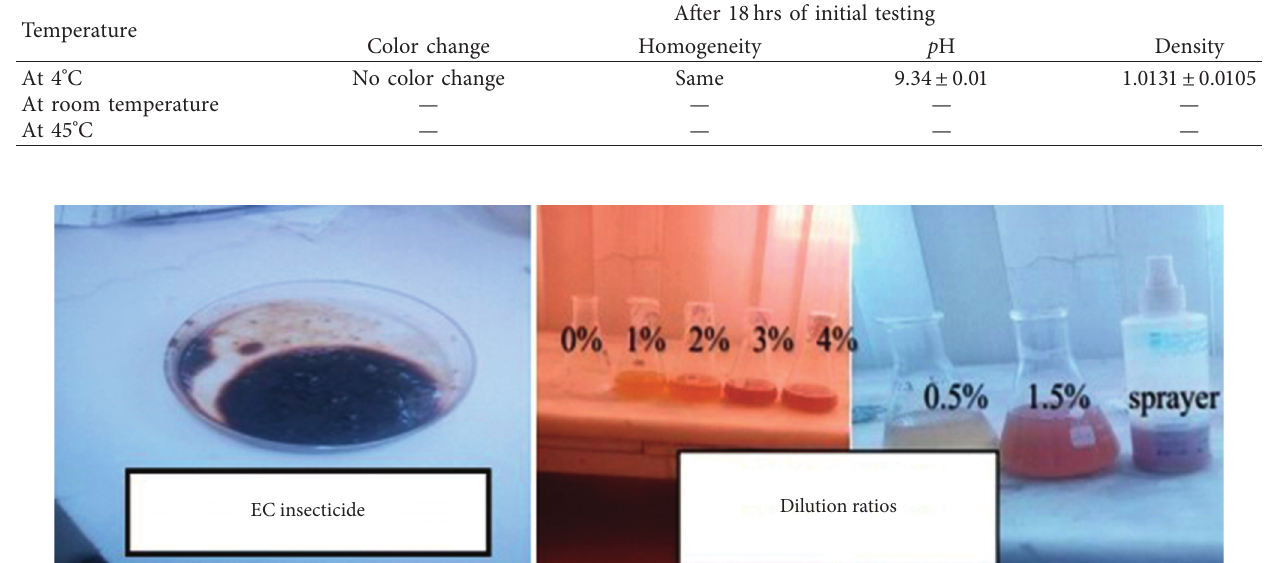
Figure 11: Efficiency testing of emulsified concentrates. Table 12: Dilution ratio of EC to solvents.